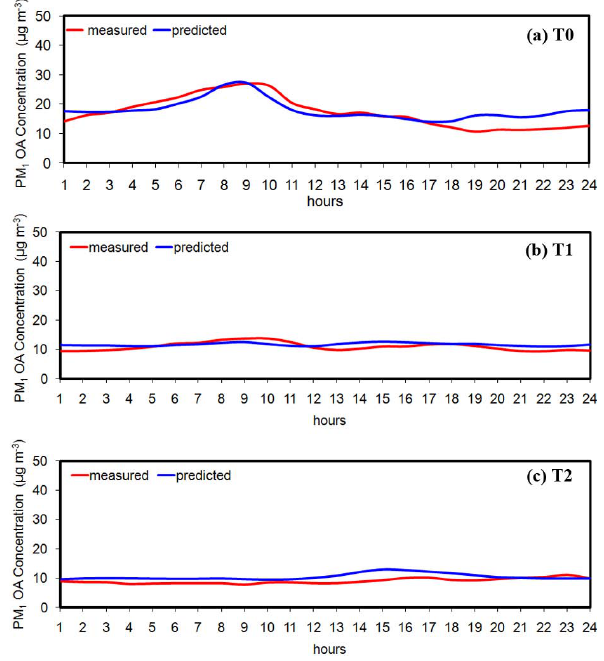
Fig. 7. Comparison of model diurnal predictions with hourly mea- surements for total PM 1 organic aerosols against measurements taken during the MILAGRO campaign in March 2006 at (a) T0 (ur- ban site), (b) T1 (suburban site), and (c) T2 (rural